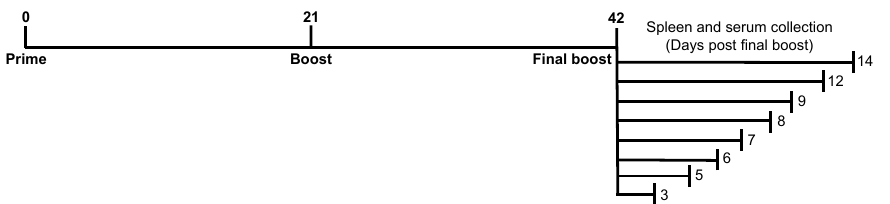
Figure 1. Schematic representation of the immunization regimen of the DBA/2J mice with the combination of COBRA Y2 (H1N1) and COBRA NG2 (H3N2) rHAs. AddaVax-adjuvanted Ags were administered intramuscularly IM or IP at day 0 and 21. Serum and spleens were harvested at the day of the sacrifice, specifically 3, 5, 6, 7, 8, 9, 12 and 14 days following the final boost with unadju- vanted Ags (at day 42) and collected serum and splenocyte samples utilized for ELISA or HAI and FluoroSpot assays, respectively.